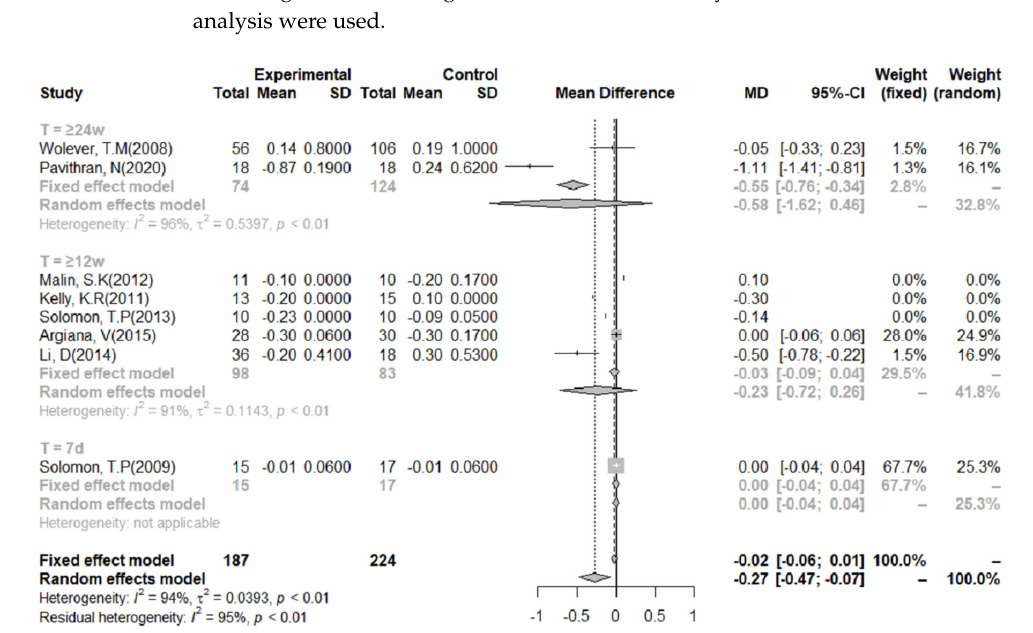
Figure 6. Meta-analysis of the effect of a low-glycemic index diet on glycated hemoglobin (HbA1c%), according to the duration of the intervention. A random-effects model and mean difference analysis were